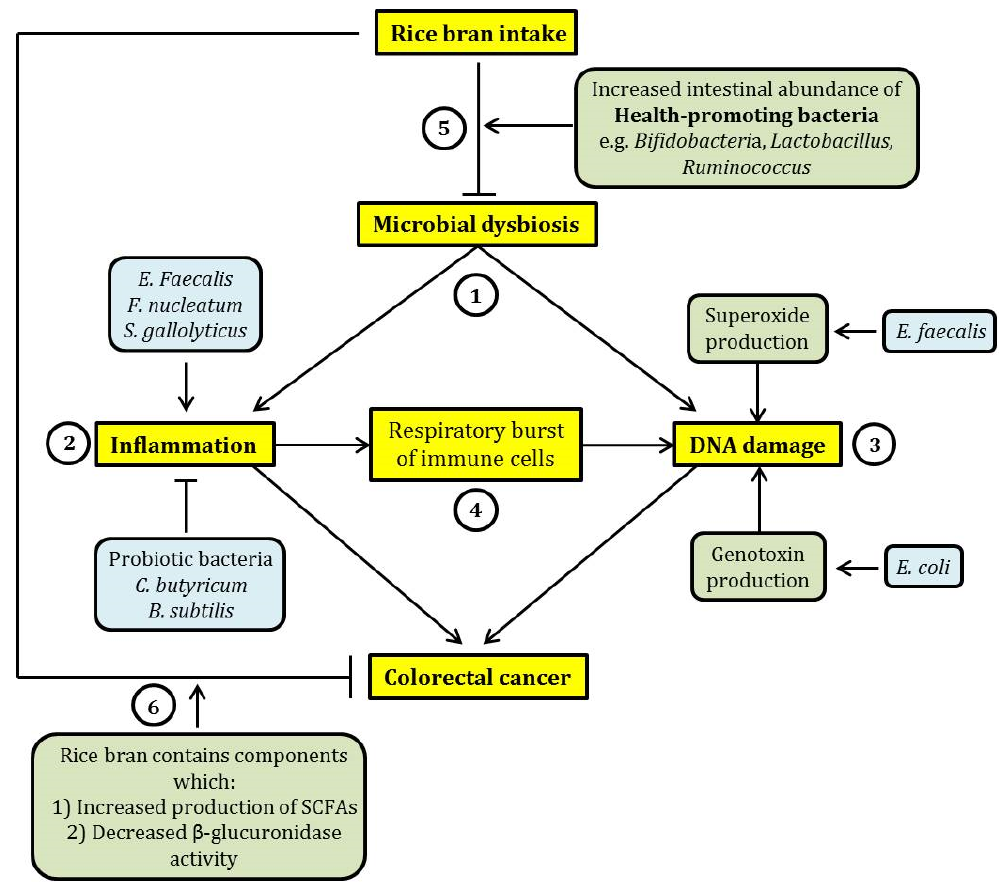
Figure 1. A schematic summary of the relationship between dietary rice bran intake, microbial dysbiosis and colorectal cancer (CRC). ( 1 ) Microbial dysbiosis may lead to CRC mainly through the induction of intestinal inflammation and DNA damage. ( 2 ) Inflammation may be exacerbated by certain pathogenic intestinal bacteria such as Enterococcus faecalis , Fusobacteria nucleatum, and Streptococcus gallolyticus , while probiotic bacteria ( Clostridium butyricum and Bacillus subtilis ) exhibit an opposing effect. ( 3 ) DNA damage induced by intestinal bacteria can be elicited through the increased production of free radicals such as superoxide (by Enterococcus faecalis ) and production of genotoxins such as colibactin (by Escherichia coli ). ( 4 ) Further, inflammation may lead to an increase in proinflammatory cytokine production by immune cells through respiratory burst. This effect may cause DNA damage through oxidation. This suggests a relationship between inflammation and DNA damage induced by microbial dysbiosis. ( 5 ) The consumption of rice bran may reverse microbial dysbiosis through the expansion of the population of health ‐ promoting bacteria, such as Bifidobacteria and Lactobacillus , in the intestine. This may potentially ameliorate the detrimental and cancer ‐ causing effects of microbial dysbiosis. ( 6 ) In addition, rice bran intake has a beneficial effect on intestinal health because rice bran contains chemicals that were previously shown to exhibit cancer chemo ‐ preventive effect, by eliciting an increased production of short ‐ chain fatty acids (SCFAs) and inhibiting the activity of β‐ glucuronidase. In the figure, arrow ‐ headed lines indicate “promotion” and bar ‐ headed lines indicate “inhibition”.